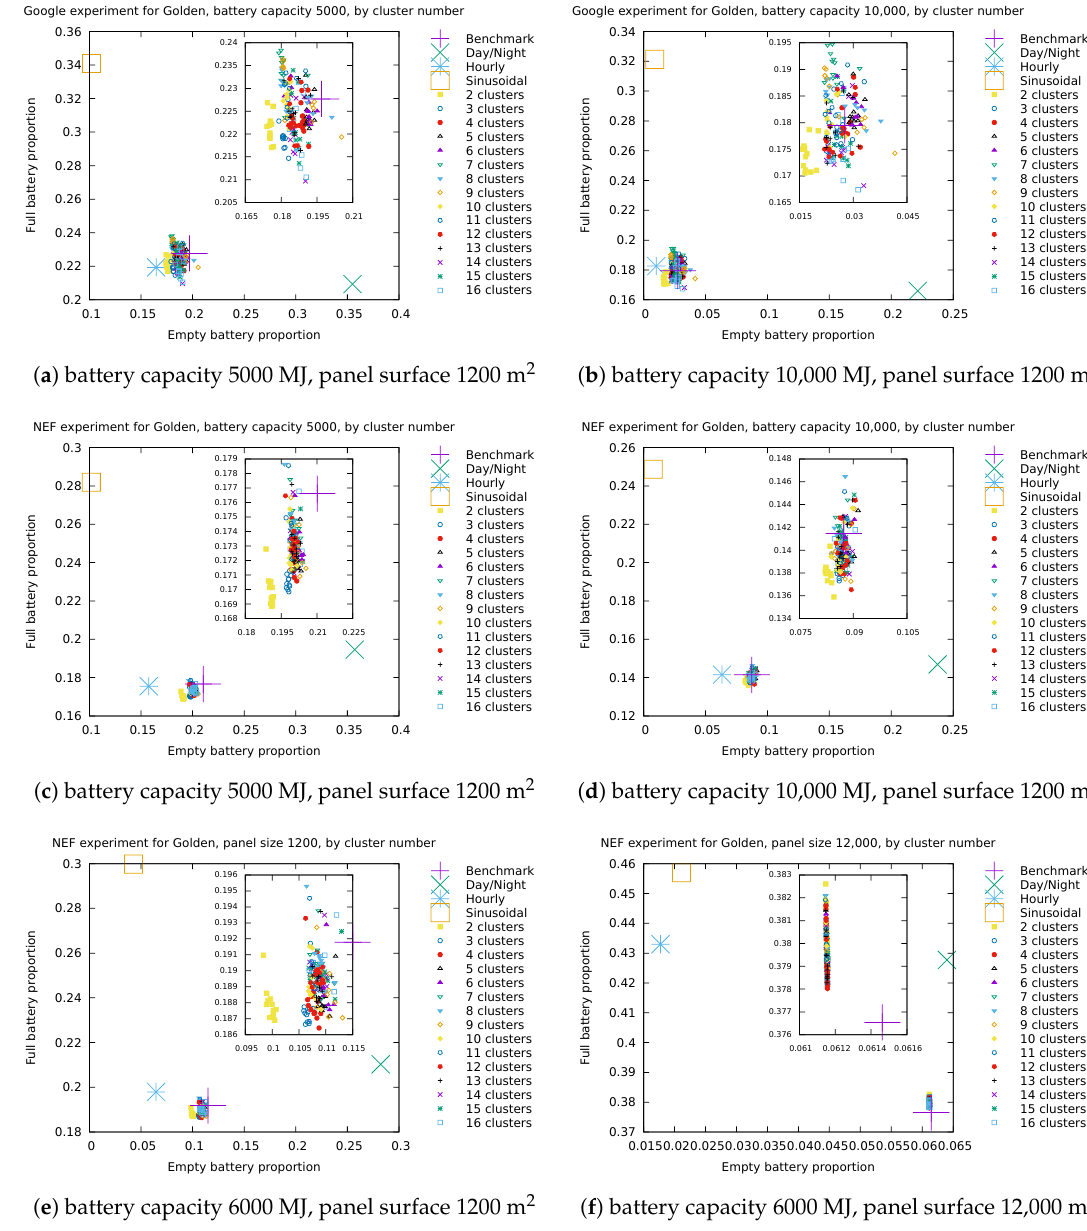
Figure 13. Golden experiments with Google consumer ( a , b ) and NEF consumer ( c – f